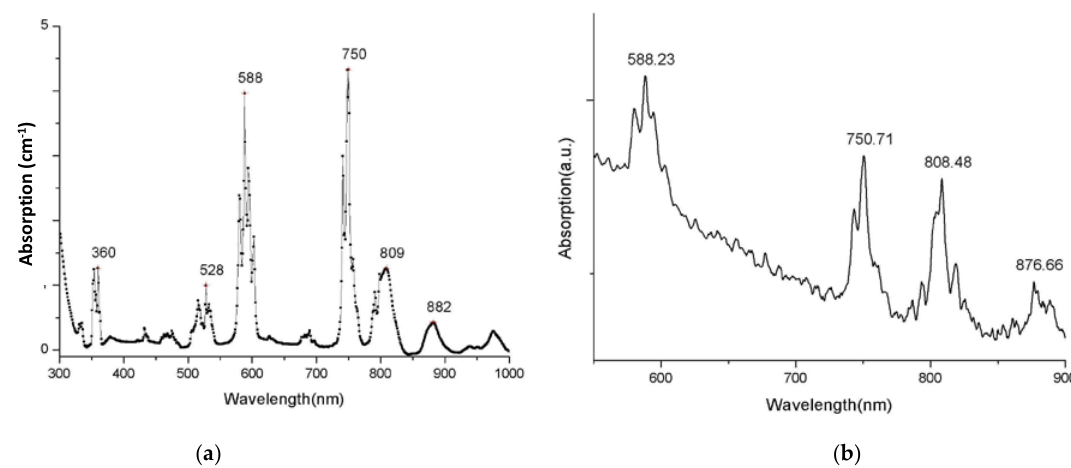
Figure 7. ( a ) Absorption spectrum of a polished slice of bulk Nd:YAB and ( b ) uncorrected absorption spectrum of Nd:YAB crystalline thin film, along the guiding direction, showing intensity peaks at 588, 750 and 808 nm, attributed to transitions from 4 I 9/2 to 4 G 5/2 , 4 F 7/2 and 2 H 9/2 , respectively. The near-infrared fluorescence spectra of the Nd:YAB thin film (thickness 71 μ m), and a bulk Nd:YAB crystal sample at room temperature, are overlaid in Figure 8. This spectrum was obtained